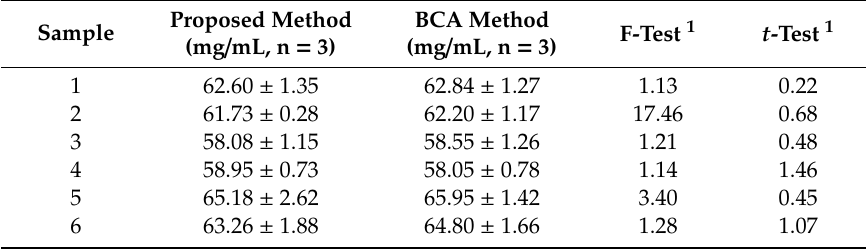
Figure 5. Fluorescence intensities of (a) 0.5 mg / mL ATT-AuNCs, (b) 0.5 mg / mL ATT-AuNCs + 500 µ g / mL HSA, and (c) 0.5 mg / mL ATT-AuNCs + 500 µ g / mL BSA. Error bars represent the standard deviations across three repetitive experiments. Table 2. The analytical results of plasma total